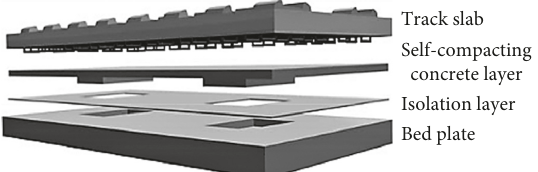
Figure 1: The composition of CRTS III slab ballastless track